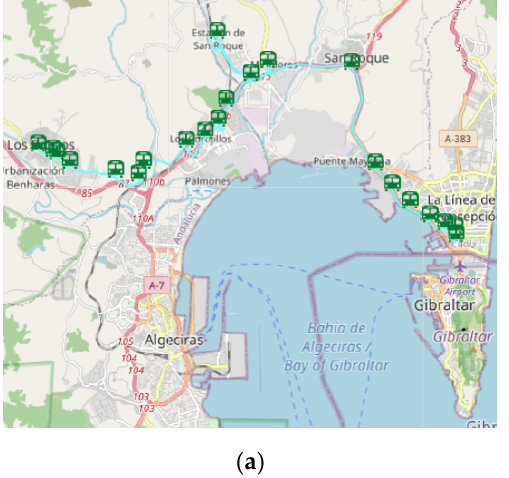
Figure 19. Line M-121: ( a ) route and ( b ) timetable.